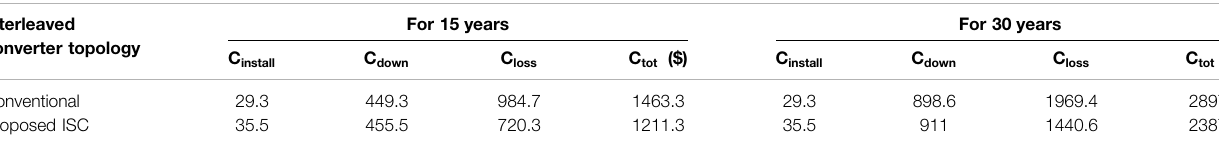
TABLE 3 | Cost comparison of conventional interleaved converter vs.